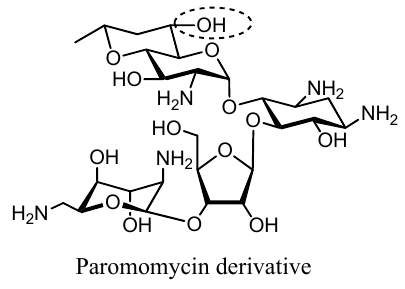
Figure 9. Structure of the Paromomycin derivative4. Inhibitors of Aminoglycoside Modifying Enzymes.